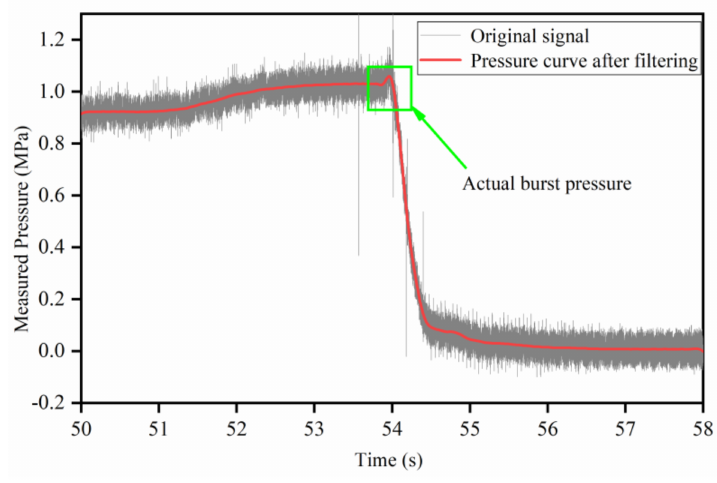
Figure 8. Pressure curve of the experimental device before-after a rupture disc opened.